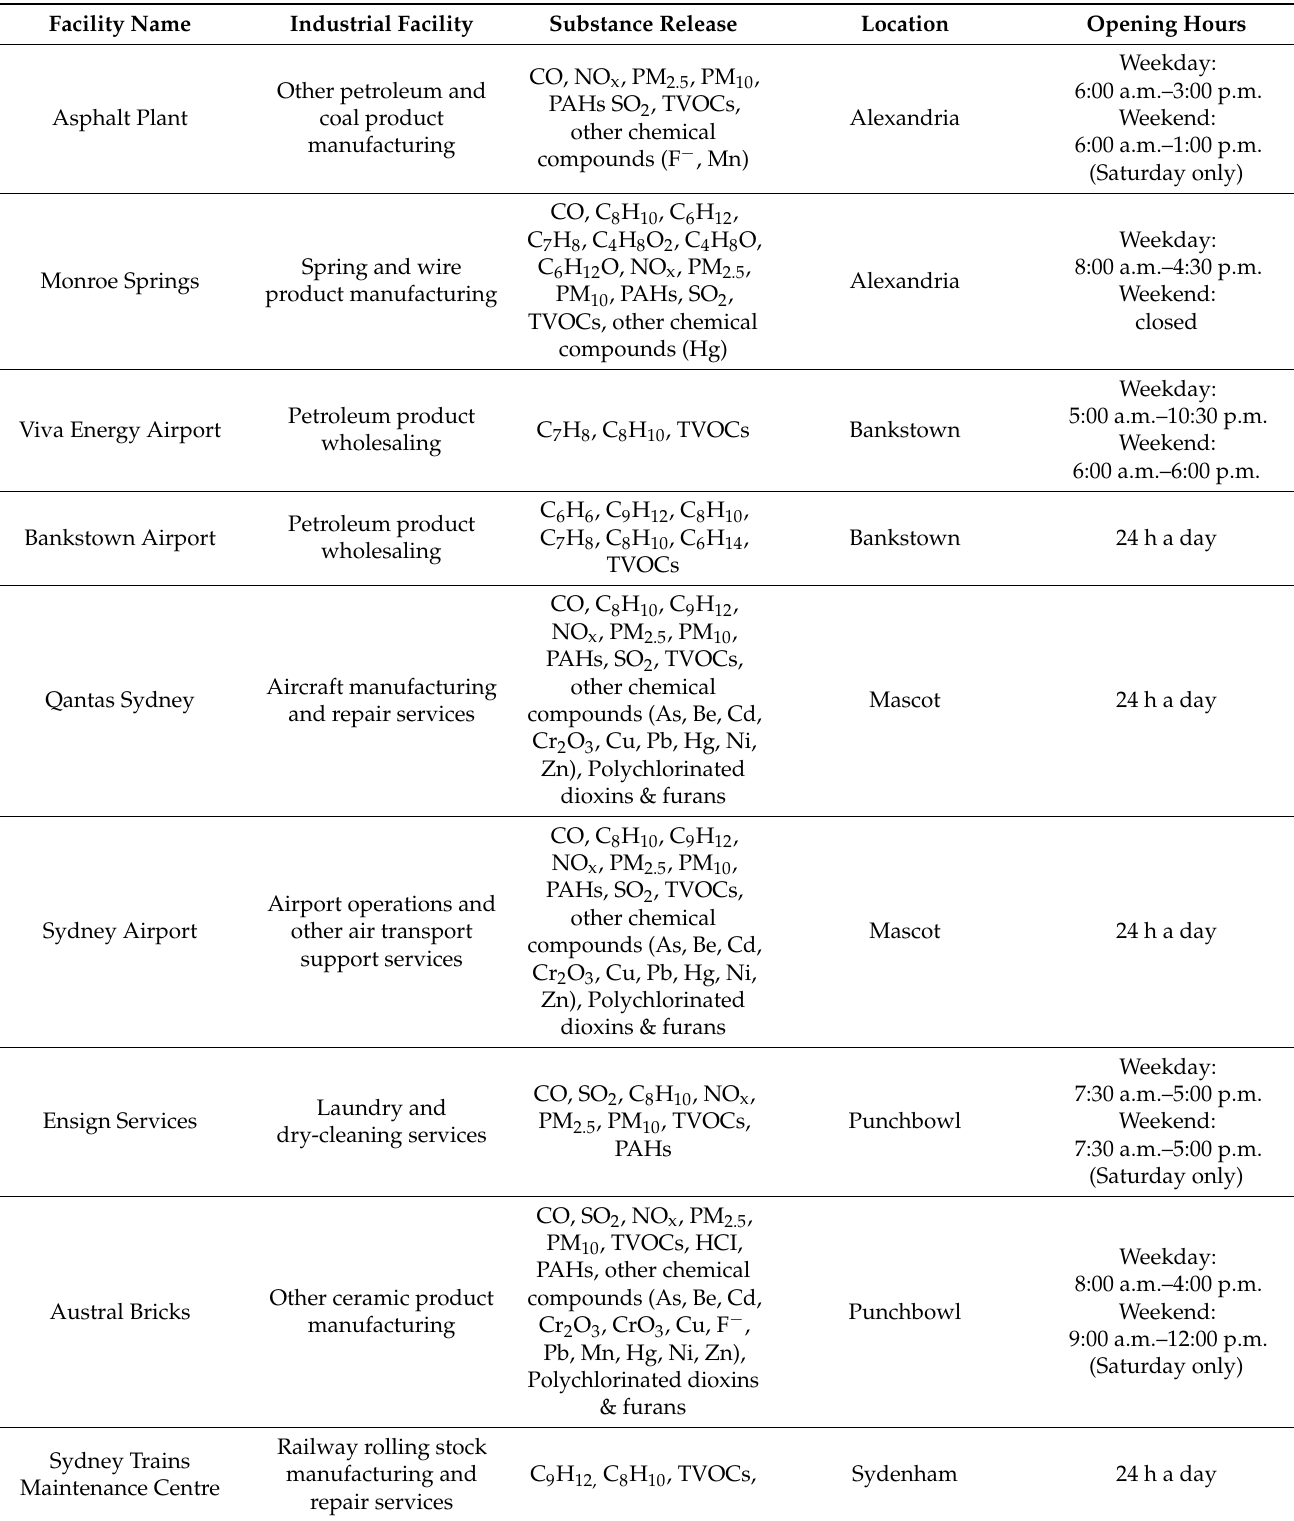
Table 2. The air pollution sources close to the project area by industrial facility